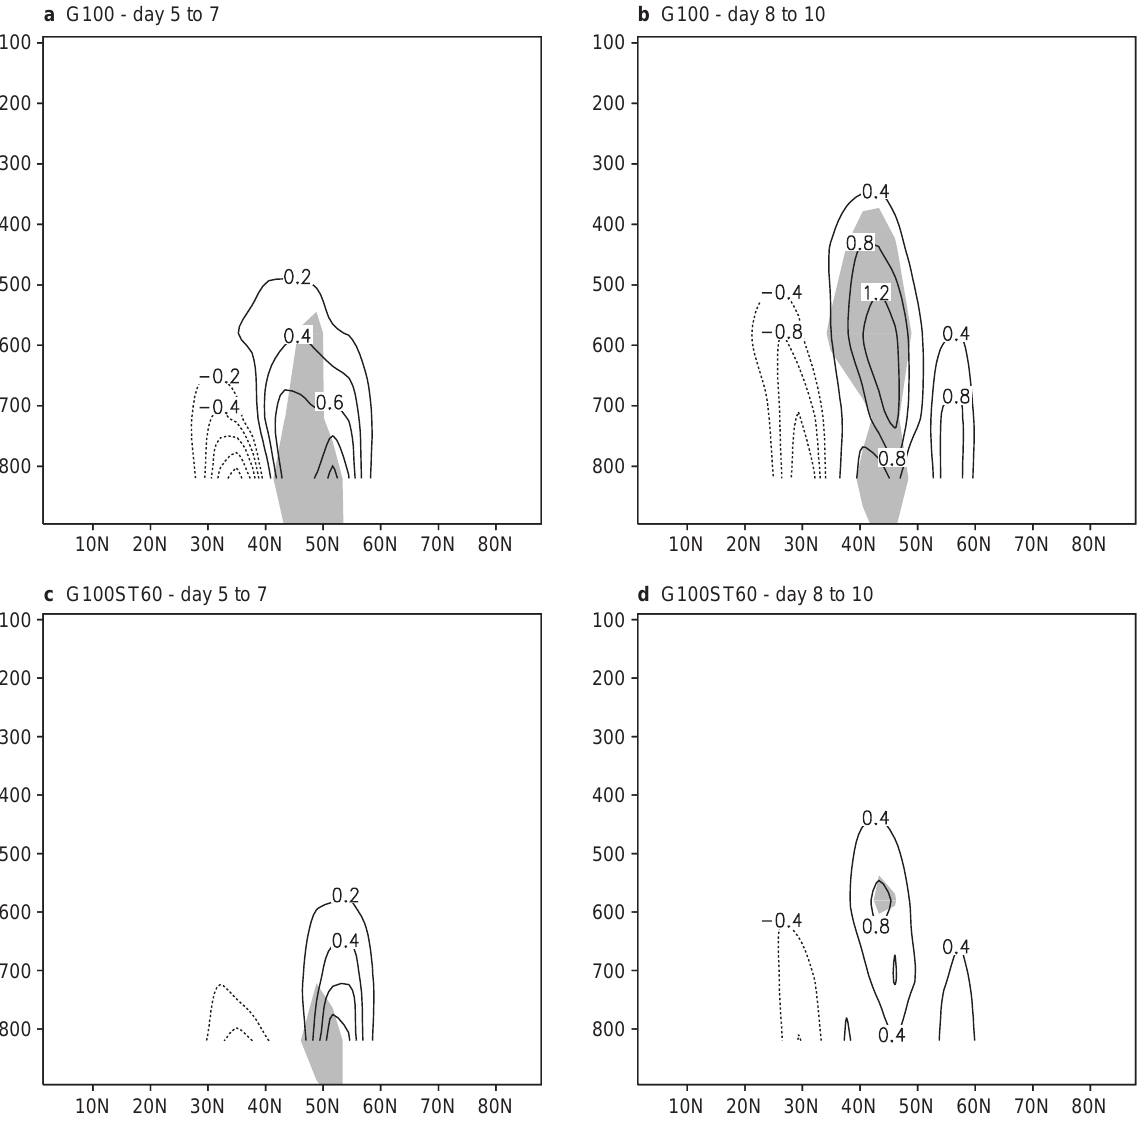
regions where the time-average zonal mean precipitated water exceeds 0.2 ( a, c ) or 0.4 ( b, d ) in the same units. These correspond to maxima in diabatic heating of a 1.2, b 2.4, c 0.8 and d 1.2 (cid:14) C